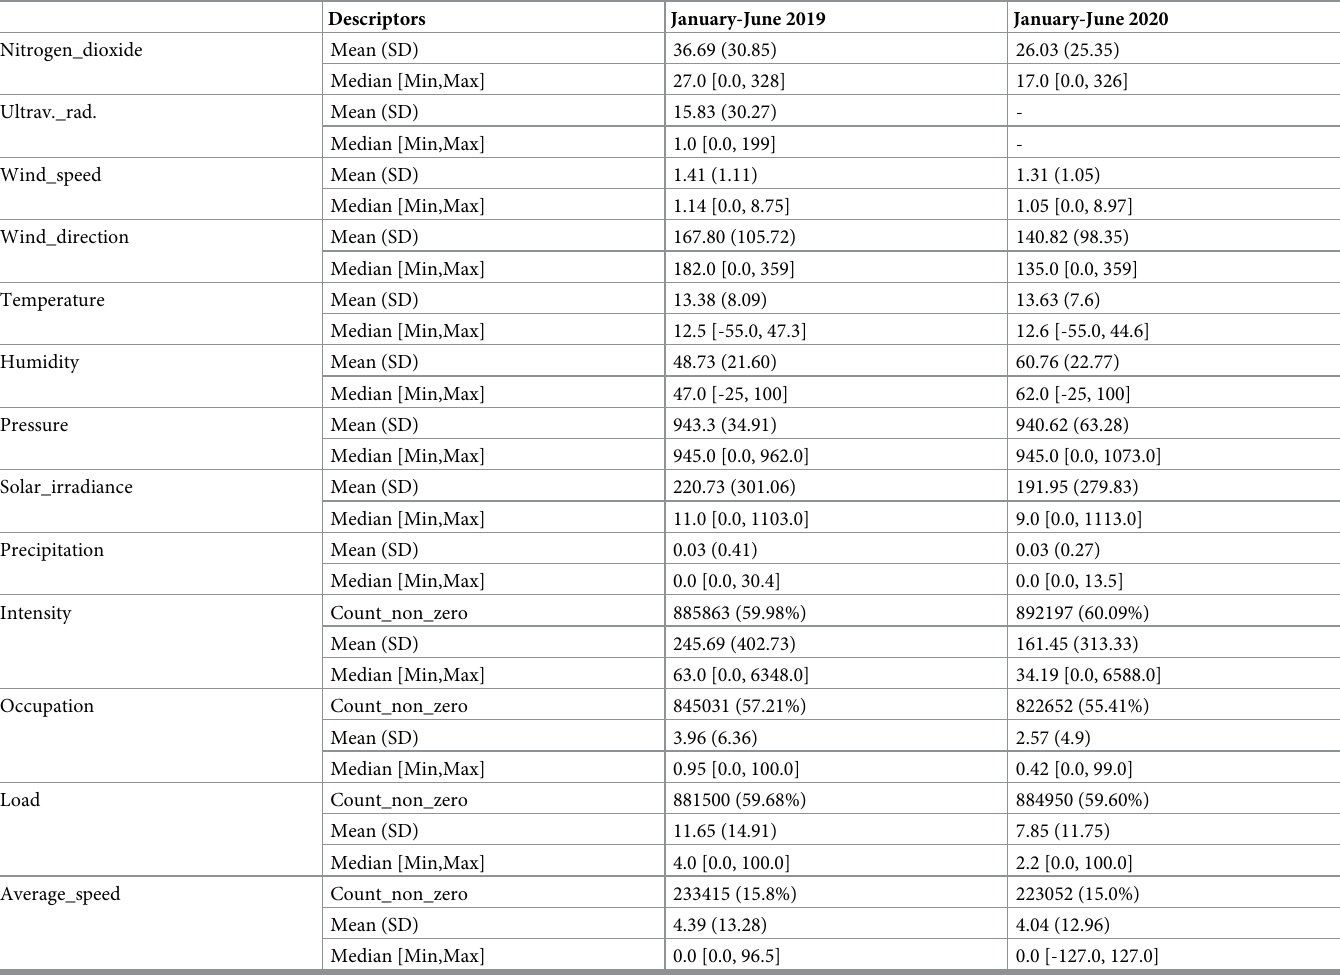
Table 2. Summary statistics of the periods January-June 2019 and January-June 2020 for each data